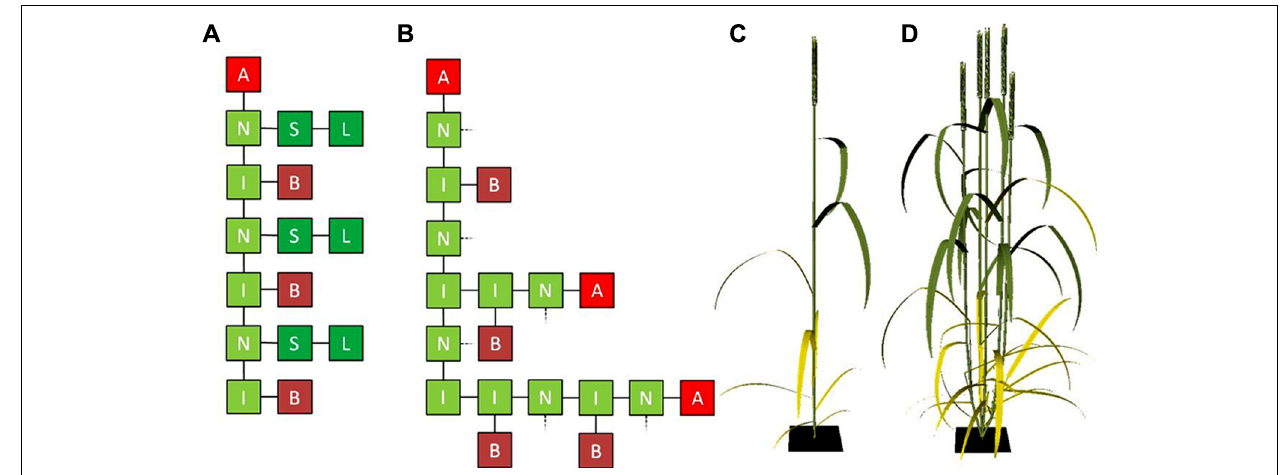
meristem. In (B) , sheaths and laminae (connected at the dashed lines) have been omitted for clarity. (C,D) Cereal architecture simulated using L-systems, using functional–structural plant modeling (FSPM): cereal plant in flowering stage with no tillers (C) and with four tillers (D)